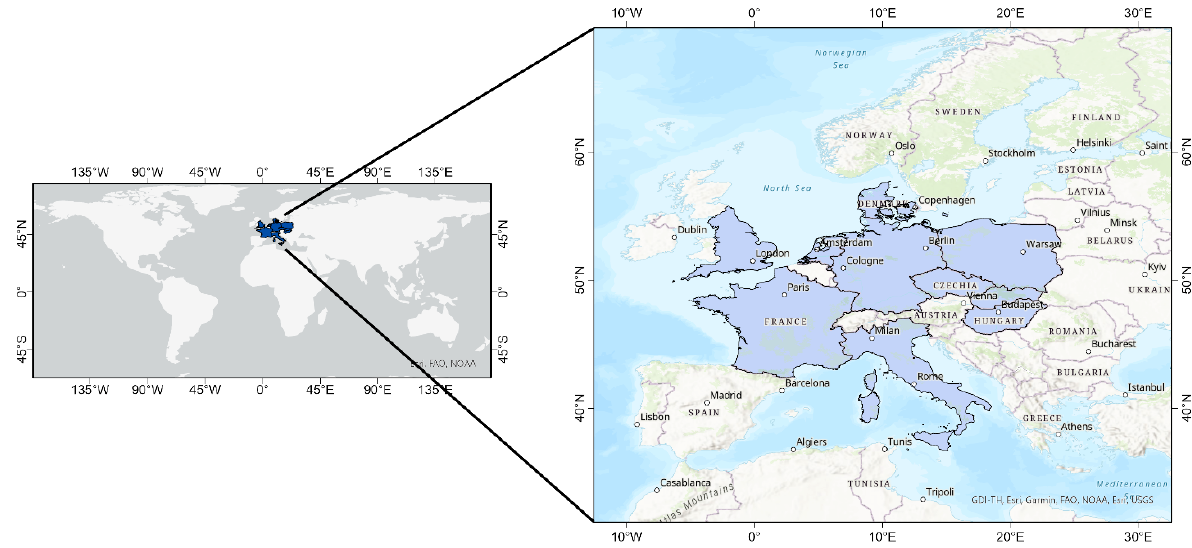
Figure 1. The study area covers 10 countries across the European Union.